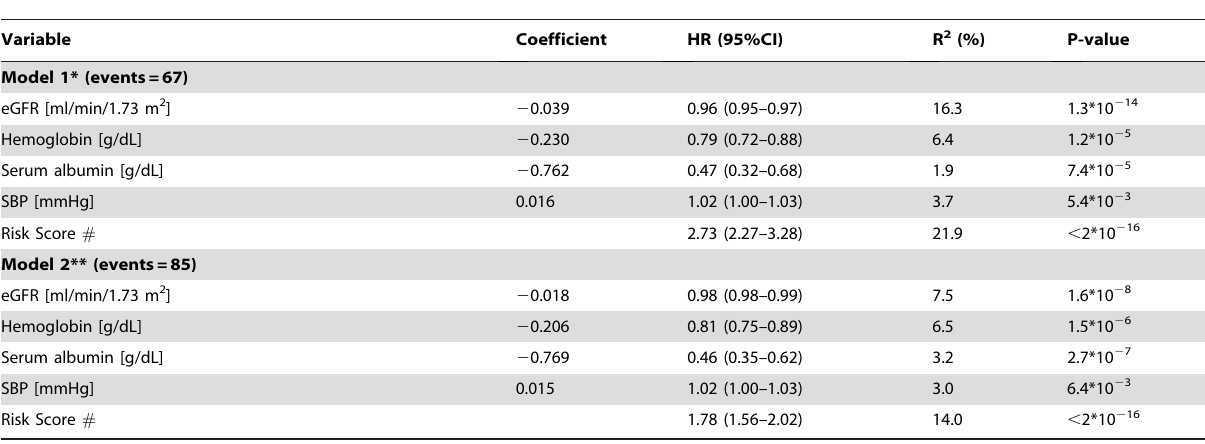
Table 3. Multivariate Cox Regression with Stepwise Selection (n=